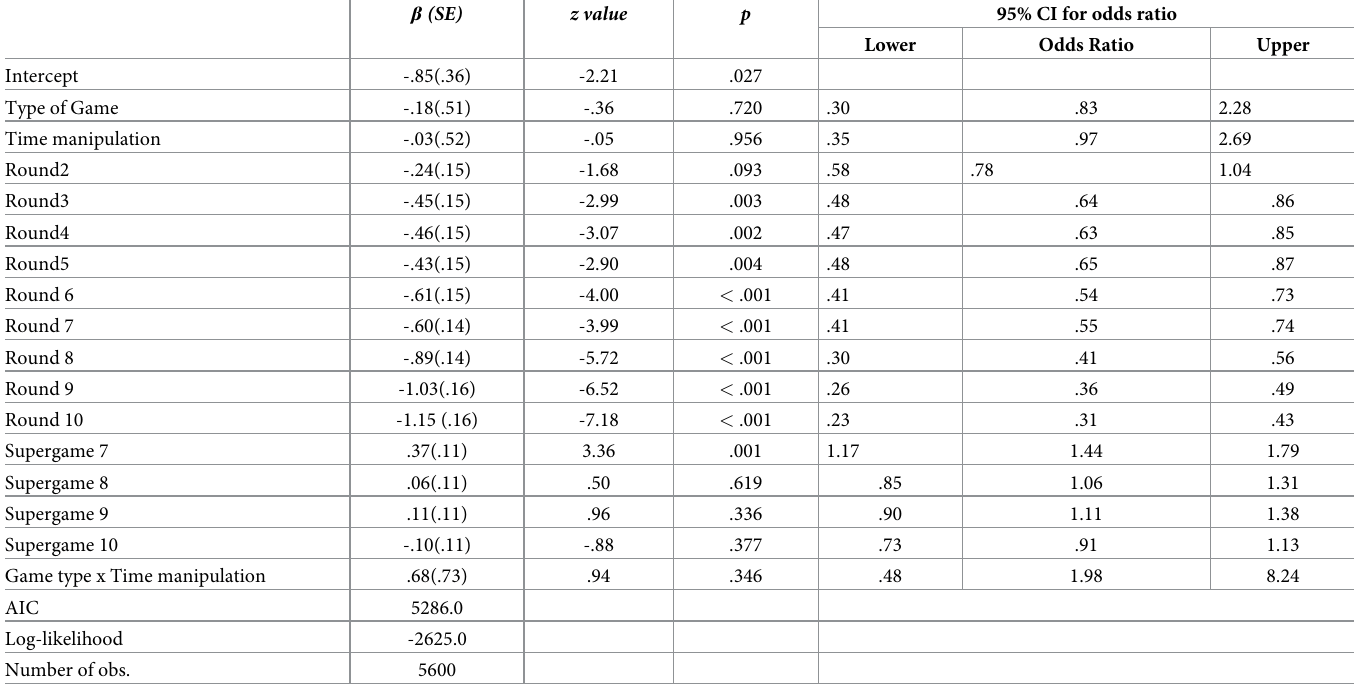
Table 5. Estimates of the logistic regression model for cooperation probability in the last 50 rounds